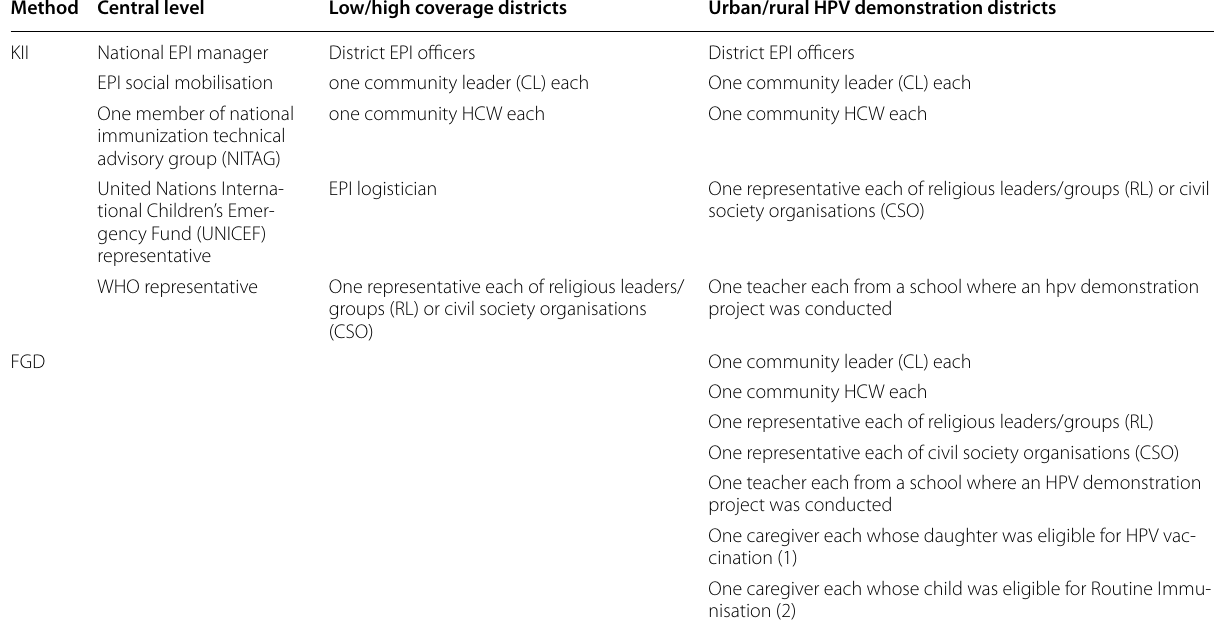
Table 1 Composition of study participants Method Central level Low/high coverage